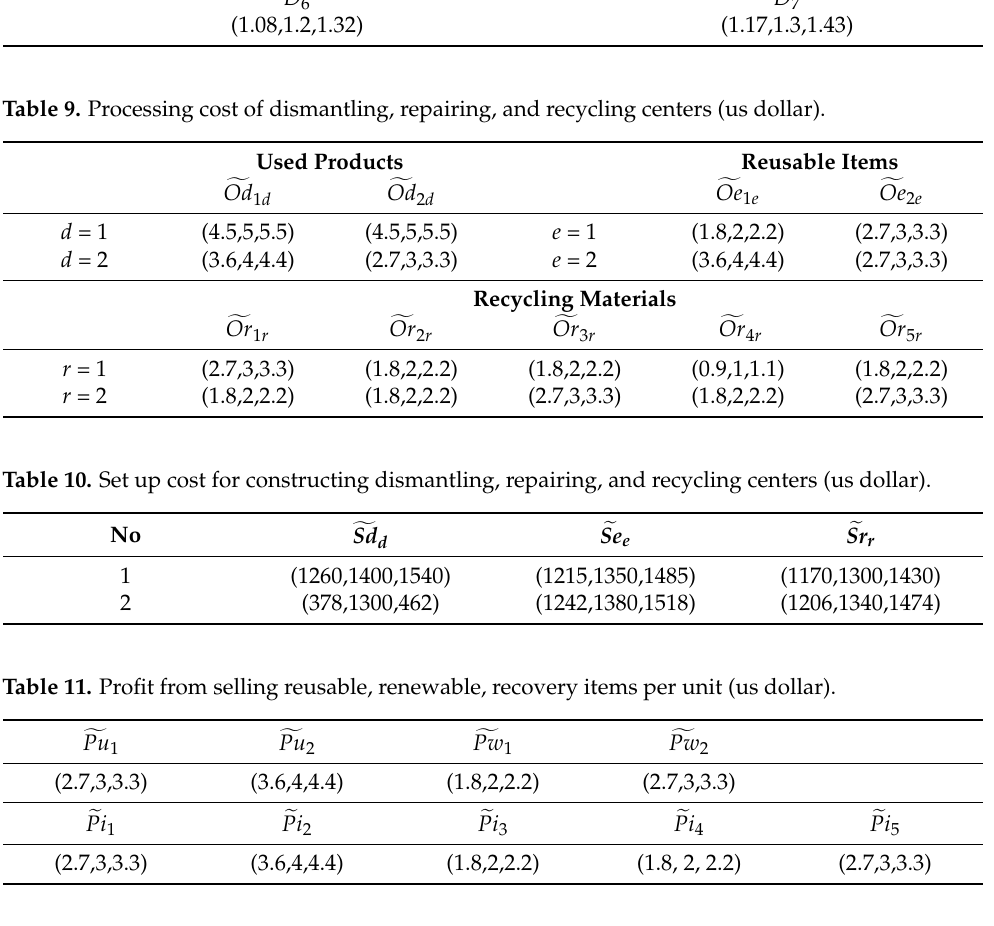
Table 12. Maximum capacity at dismantling, repairing, and recycling centers